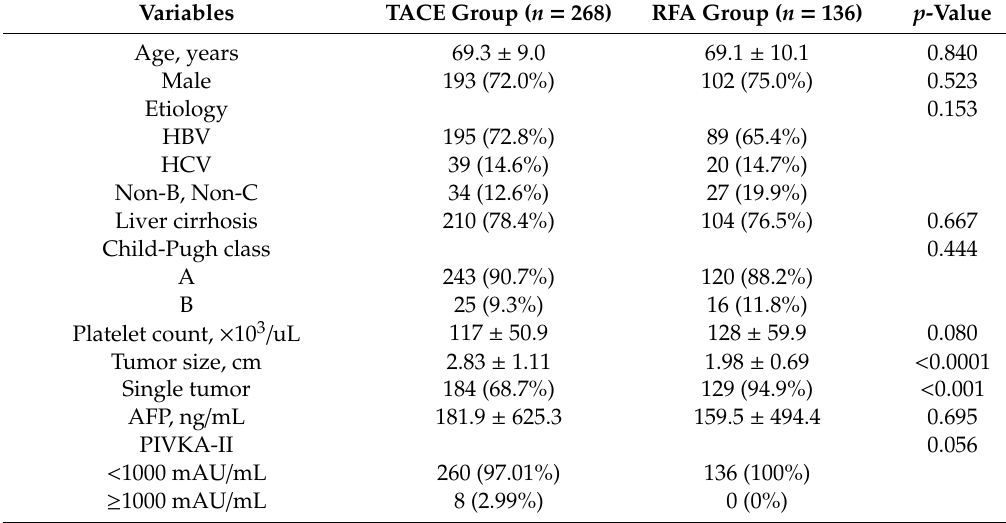
Table 1. Comparison of baseline clinical characteristics between the two groups before